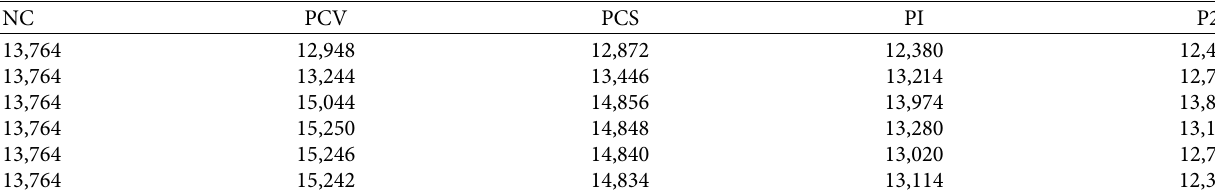
Figure 8: Profile of IL-17, Th17, Th-reg, and ratio Th17 T-reg. Table 3: The result of weighting every piece of intestinal ligated in the